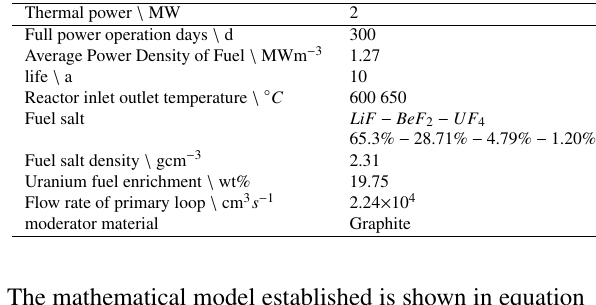
Table 1. Overall design parameters of 2MW MSR Thermal power MW \